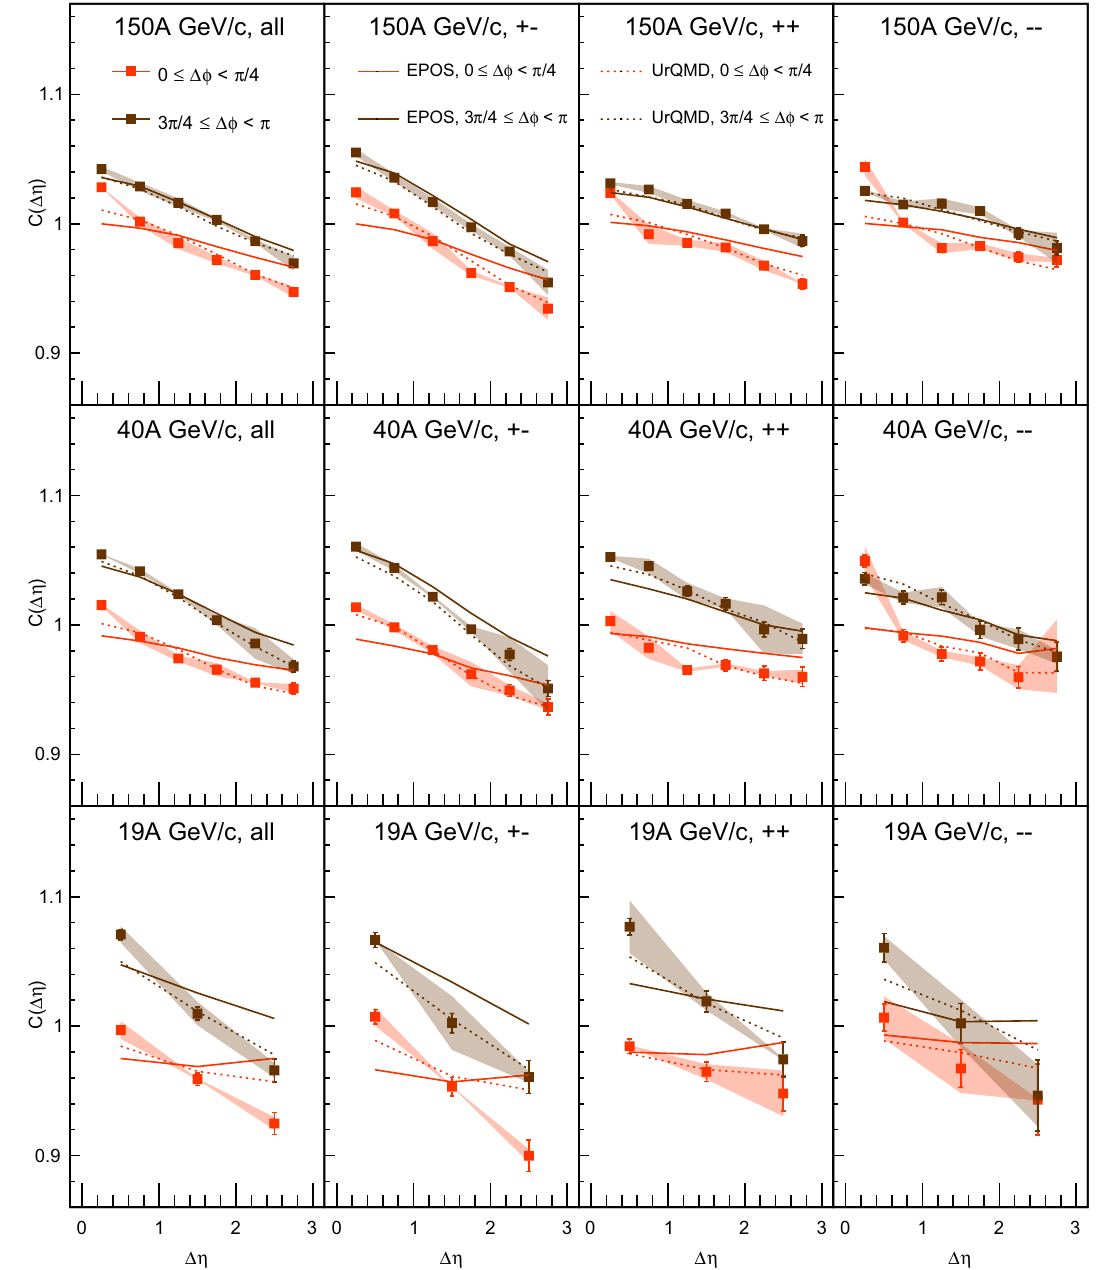
Fig. 16 Two-particle correlation function C ((cid:2)η) obtained from pro- jectionof C ((cid:2)η,(cid:2)φ) ontothe (cid:2)η axisforsubrangesof (cid:2)φ .Fromleftto right the columns show respectively: all charge pairs, unlike-sign pairs, positive charge pairs, and negative charge pairs. Vertical bars denote